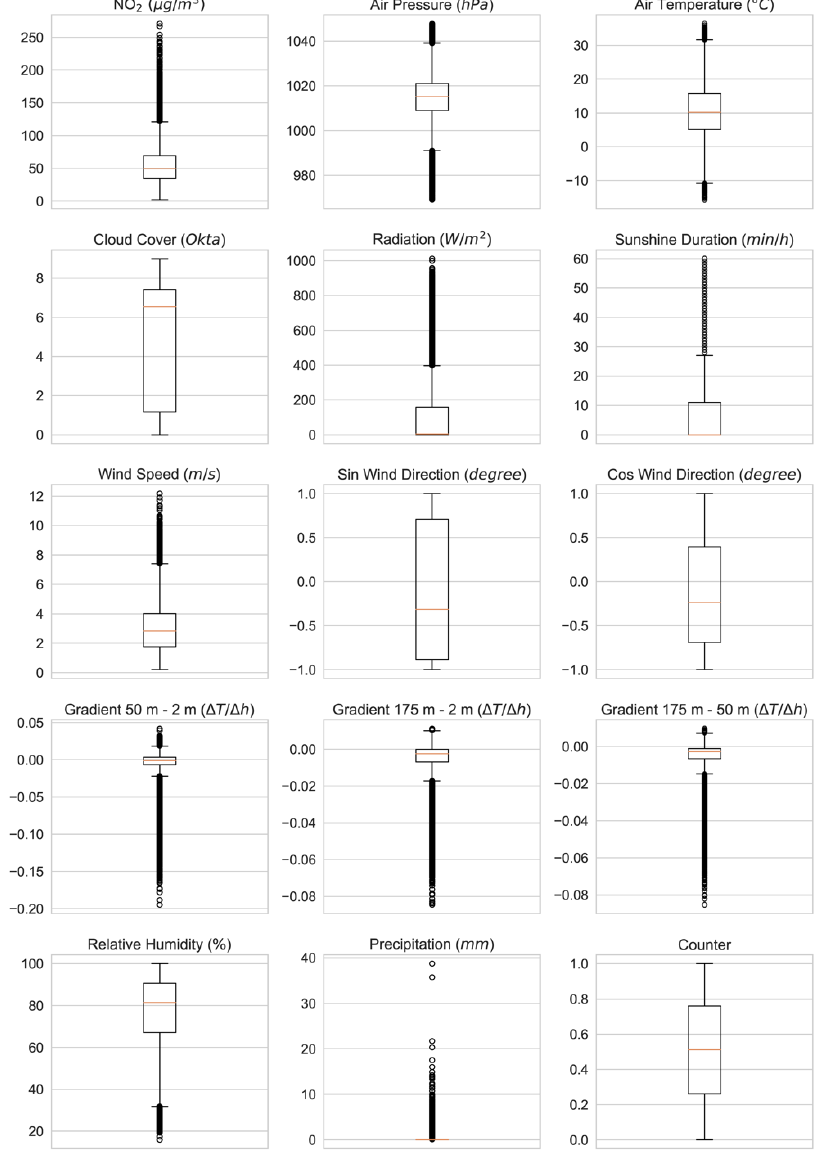
Figure 2. Boxplots of the numerical input variables.